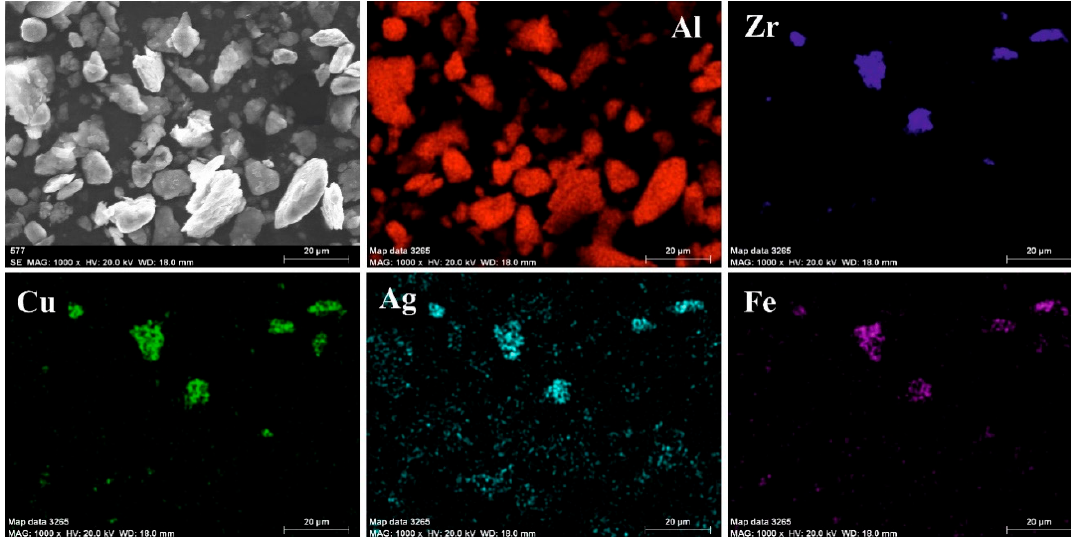
Figure 3. Backscattered SEM images ( a ) and particle size distribution ( b ) of mixed powders milled for different periods of time. di ff erent periods of time.